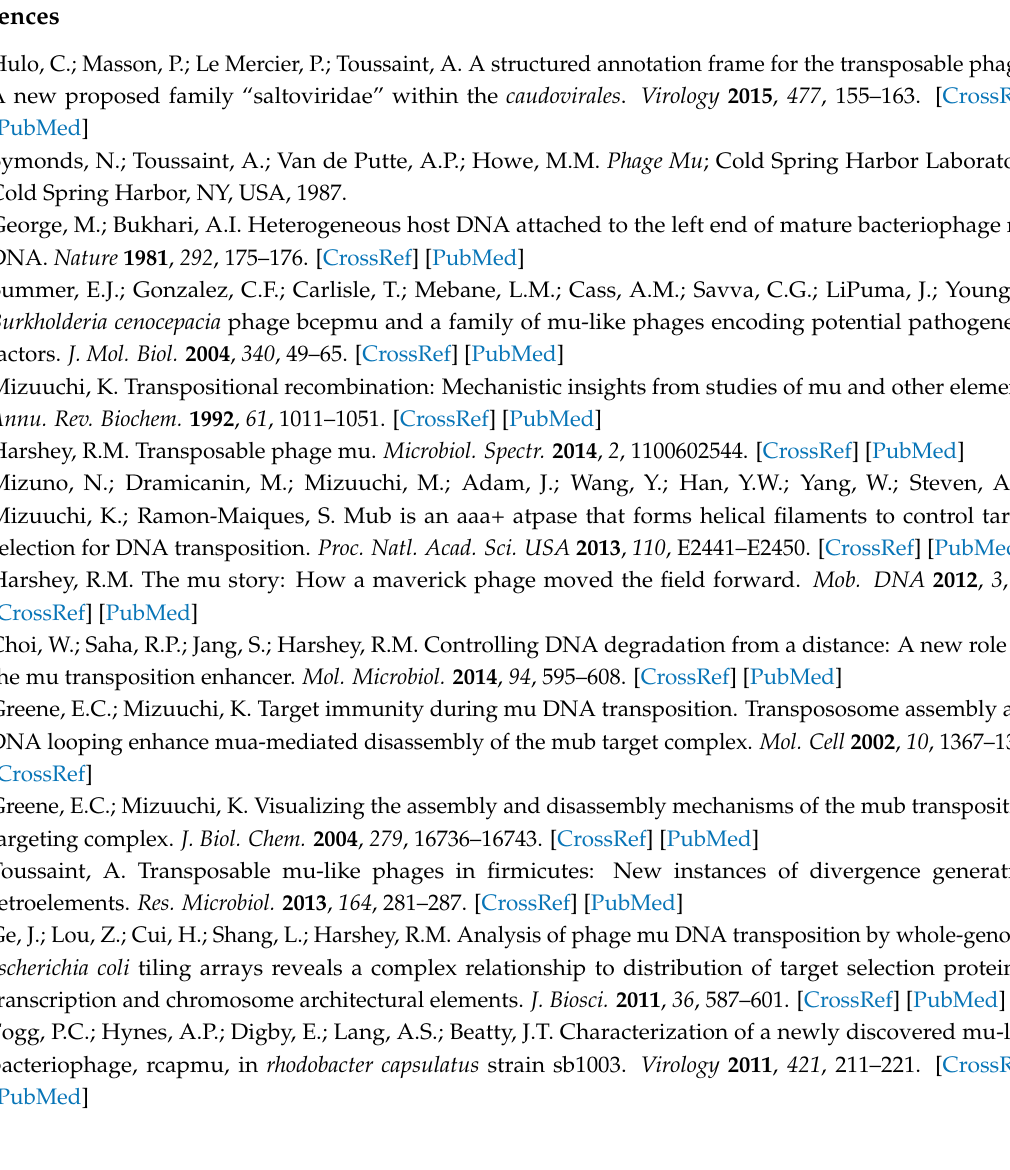
Figure S1: the enrichment in Ab30 phage ends; Figure S2: clustering analysis of the phage’s genome sequences including close neighbors; Figure S3: phage 2P1 distribution of transposition sites in host strain genome PcyII-10; Figure S4: detection of a conserved region in the vicinity of the fourteen strongest Ab30 transposition hotspots; Figure S5: Mapping of 25,000 Ab30 transposition sites across PAO1 illustrates the difference with the HW12 behavior and the similarity with 2P1; Figure S6: the correlation of transposition cold-spots with low GC content segments; Figure S7: a candidate for a Strong Gyrase-binding Site in the phage domain; Table S1: coincident insertions, expected and observed in the three phages; Table S2: the association between VNTR loci and Ab30 hotspots; and Table S3: the position of hotspot associated motifs and amount of associated events (maximum and